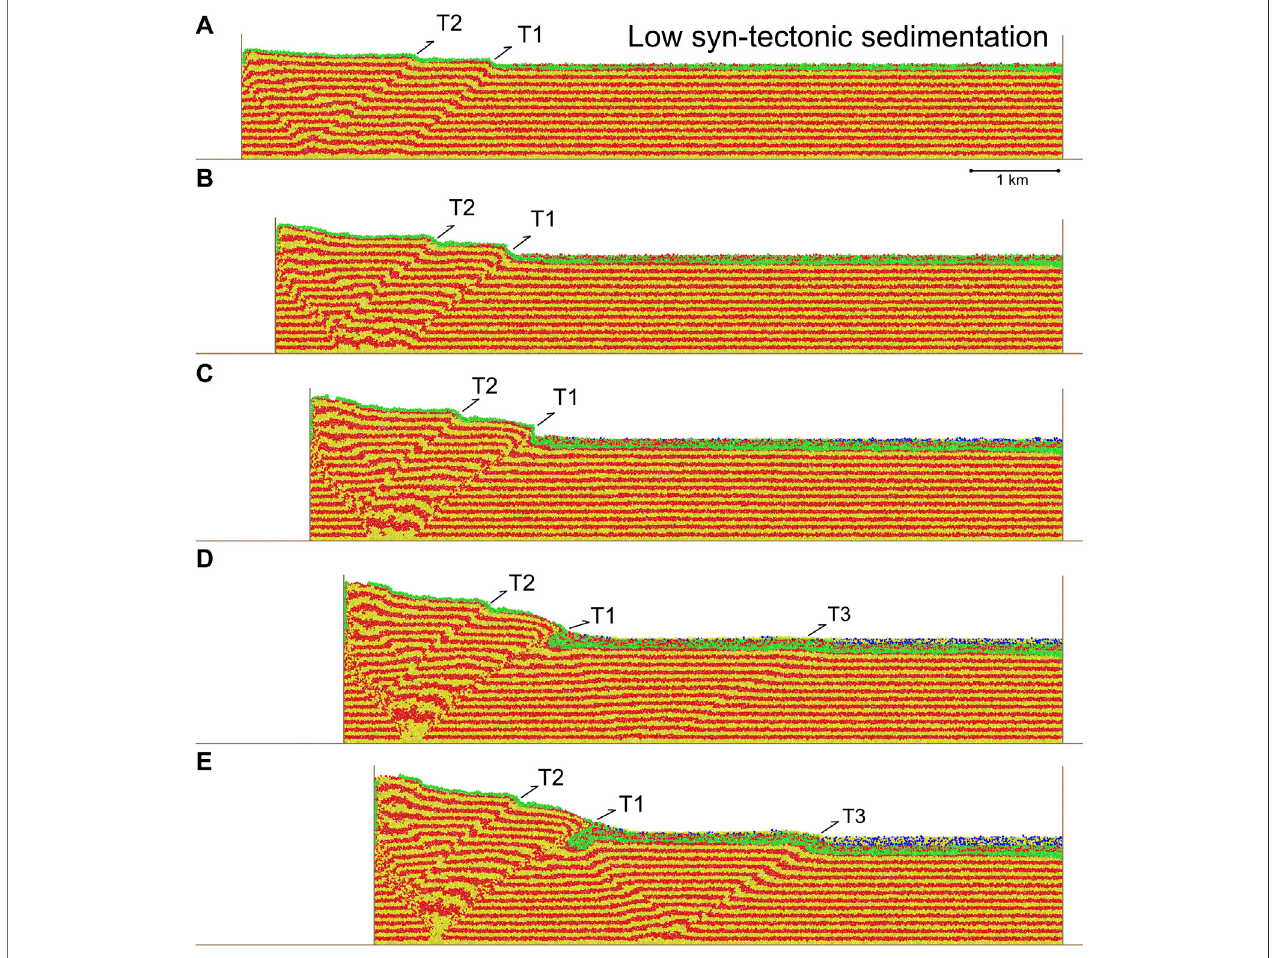
FIGURE 3 | Experiment 2, progressive evolution of a contractional model with “ low ” syn-tectonic sedimentation. Results are shown after 500 (4%), 1,000 (8%), 1,500 (12%), 2,000 (16%), and 2,500 (20%) m contraction/displacement on the left-hand end-wall. Two distinct growth packages are highlighted/coloured in order to show the stratal architectures developed inearly (green-red package) and mid/late (blue-yellow package) fault array growth, the transition occurringat c. 1,250(10%) m of lateral contraction, see text for discussion.